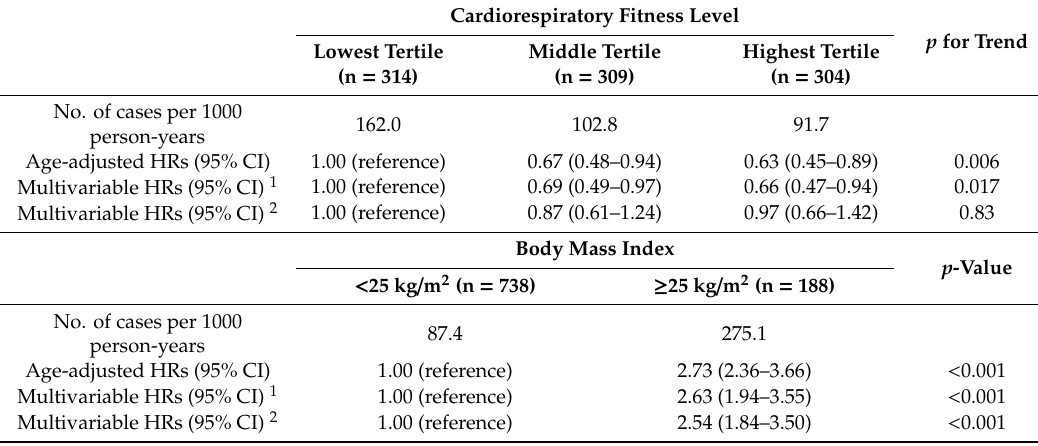
Table 2. Hazard ratios with 95% confidence intervals for the incidence of dyslipidemia based on cardiorespiratory fitness and body mass index.